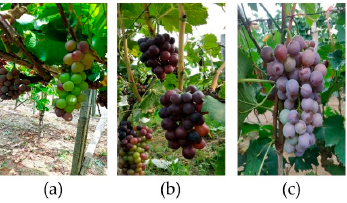
Figure 1. Color of Kyoho grapes in different growth periods: ( a ) Two grape clusters of different colors; ( b ) Different ripe grapes of different colors; ( c ) Different color from grapes in ( a , b ).